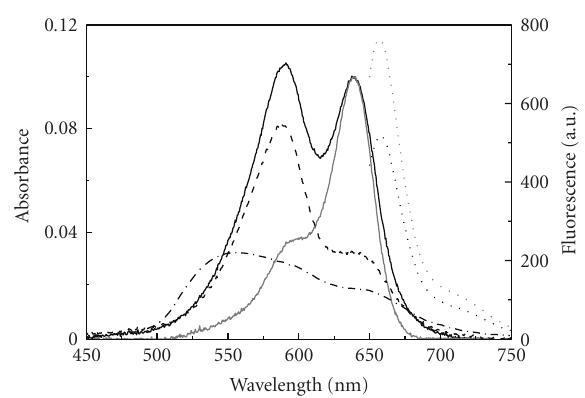
Figure 2: Absorption (solid lines) and fluorescence spectra (dotted lines) of PAH-Cy5 A (black) and Cy5 (grey). The fluorescence spectra were taken for excitation in the maximum λ ex = 638 nm. The absorption spectrum of the new species is calculated (dashed line). For comparison, the H-aggregate spectrum of Cy5/PSS is given (dash-dotted line) [16, 17].